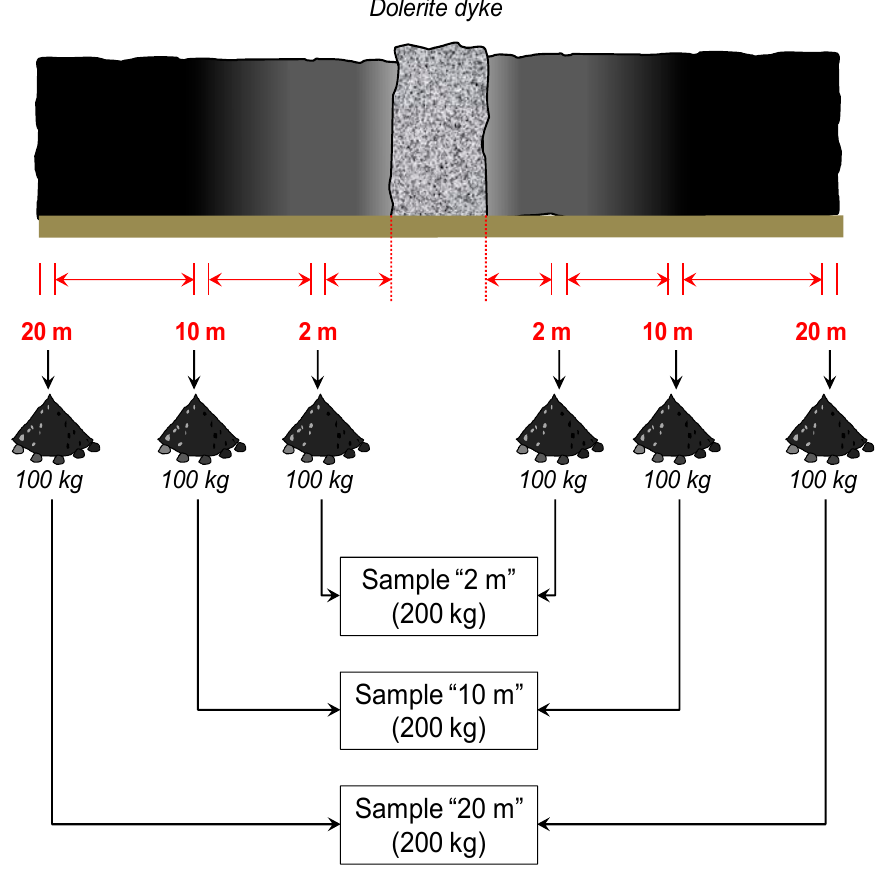
Figure 2. Sampling scheme according to the distance from the dyke.